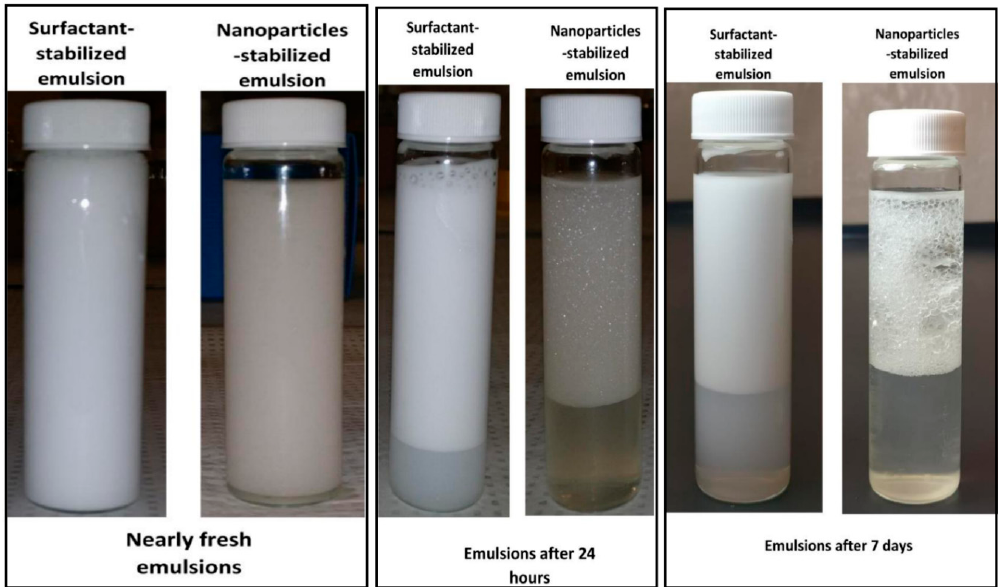
Figure 10. Images of fresh and aged surfactant-stabilized (left bottle in each box) and nanoparticles-stabilized (right bottle in each box) O/W emulsions.